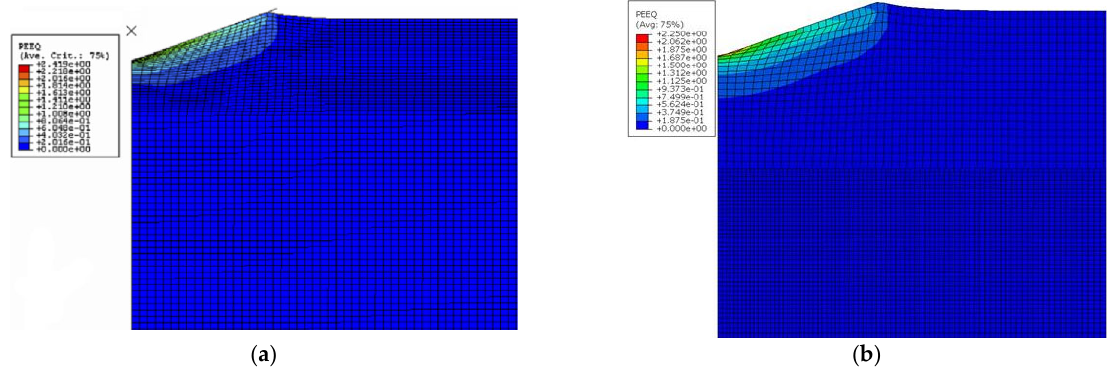
max = 900 nm: ( a ) reported result